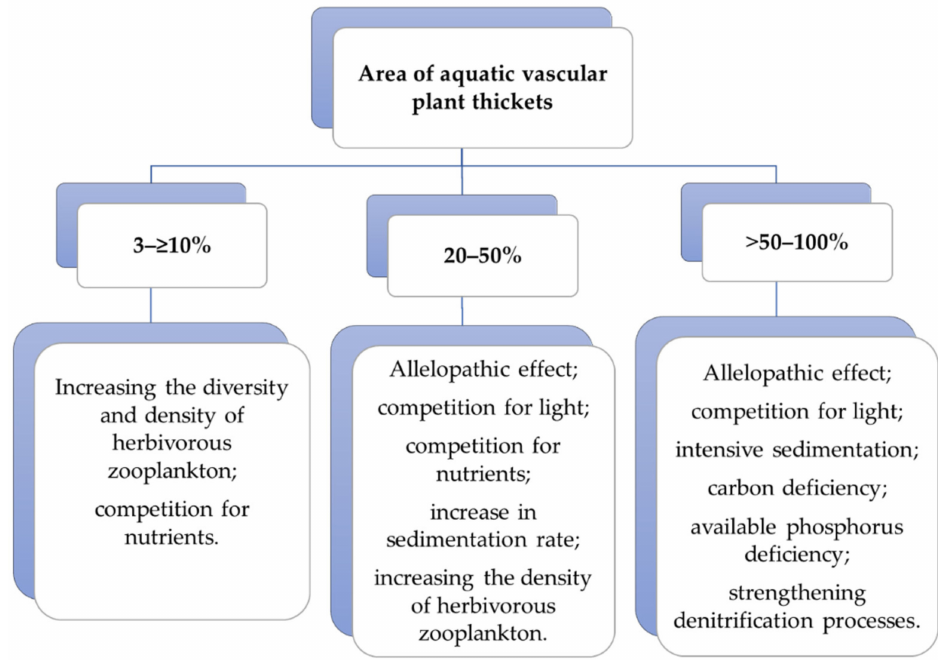
Figure 1. The mechanism of inhibition of cyanobacteria and other phytoplankton growth depends on the relative area of aquatic macrophyte thickets